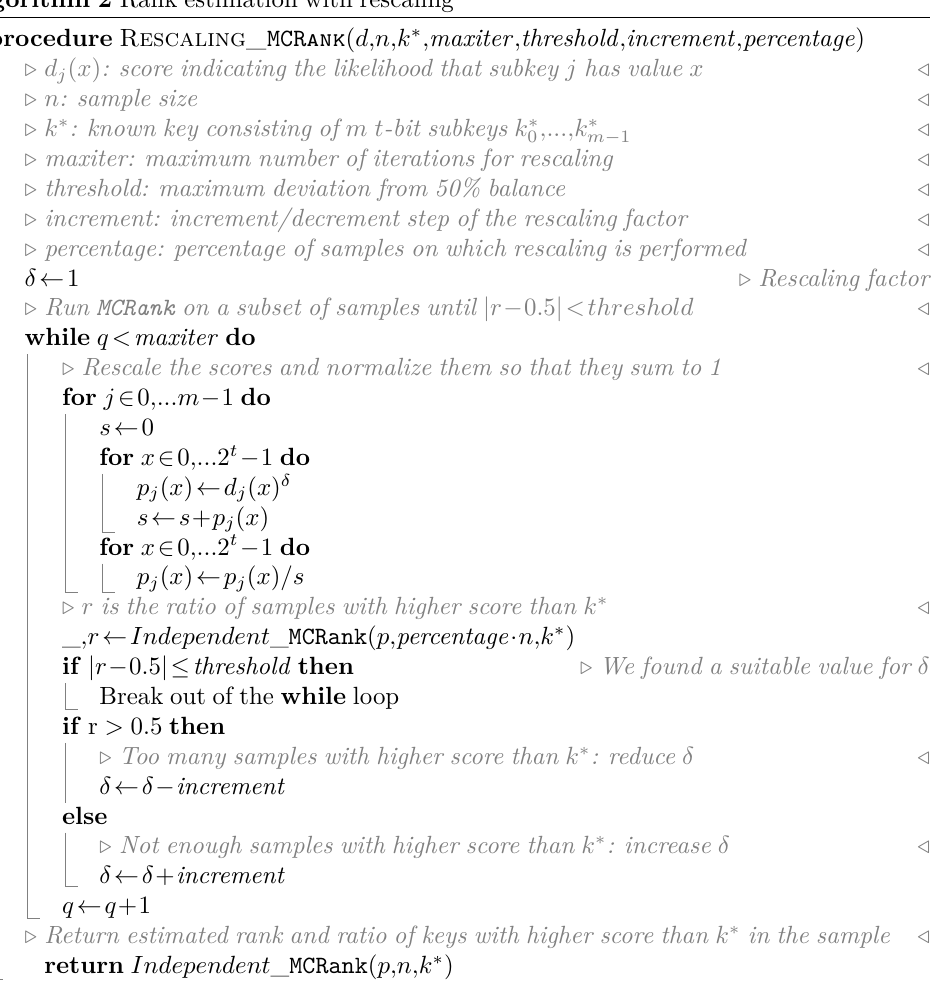
Algorithm 2 Rank estimation with